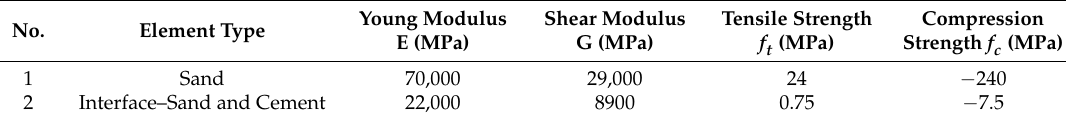
Table 5. Sand and interface material properties (from [41]).